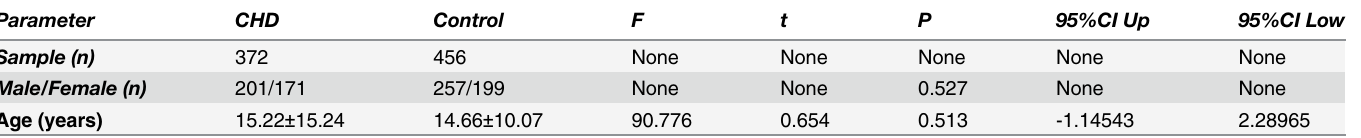
Table 1. Clinical characteristics of study population.